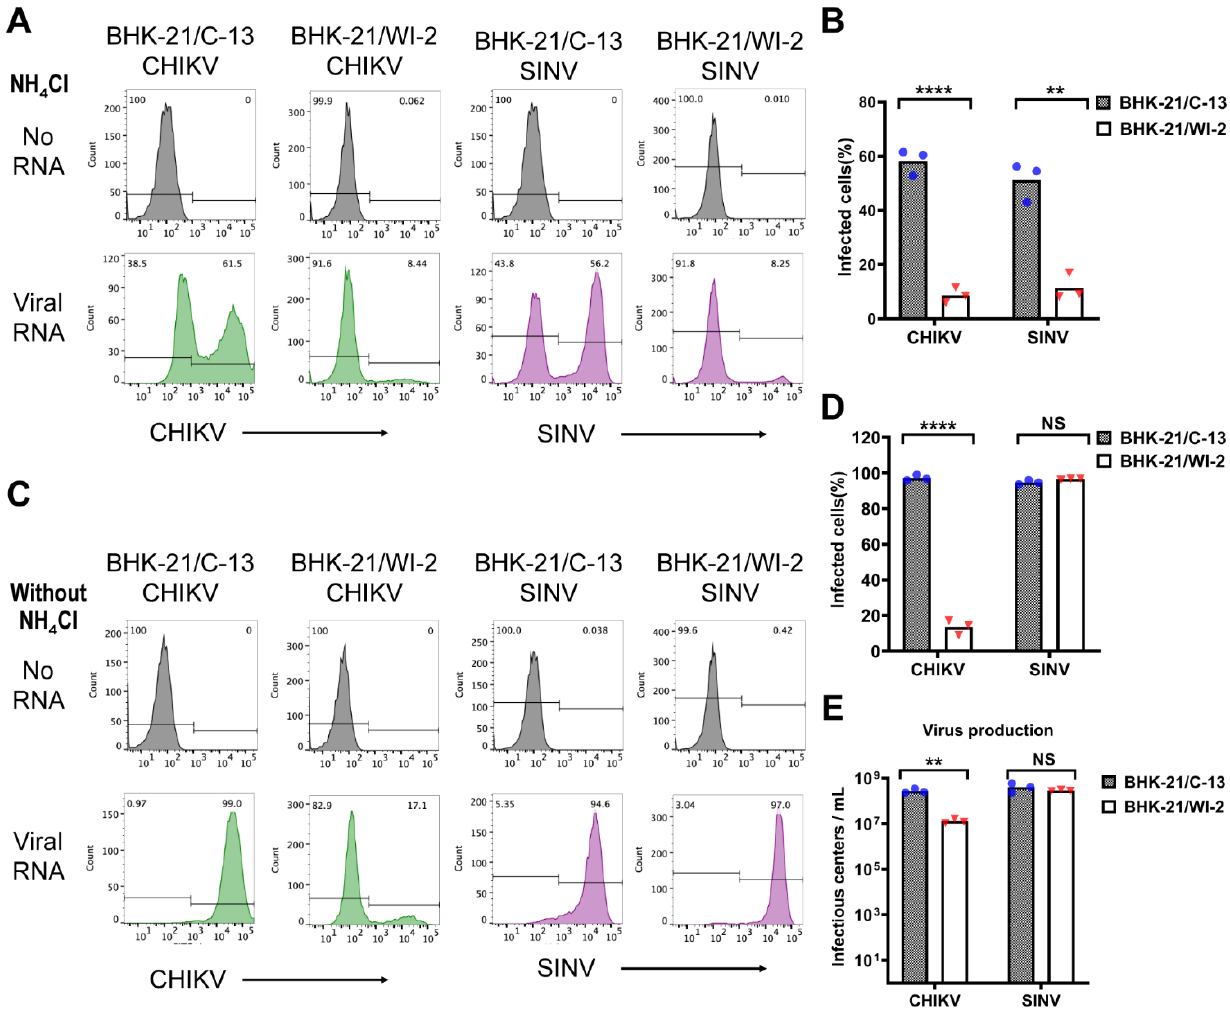
Figure 3. Viral RNA electroporation efficiency of BHK-21/C-13 and BHK-21/WI-2 cells. Equivalent numbers of BHK-21/C-13 or BHK-21/WI-2 cells were electroporated in parallel with in vitro transcribed CHIKV or SINV viral RNA. ( A , B ) After electroporation, cells were cultured in complete media for 2 h at 37 °C, then incubated at 28 °C overnight in media containing 20 mM NH 4 Cl to prevent secondary infection. ( A ) Infection was quantitated by flow cytometry. A representative example of 3 independent experiments is shown. ( B ) The bar graph represents the mean and individual data points of the % infection from 3 independent experiments. ( C – E ) After electroporation, cells were cultured in complete media for 2 h, then cultured in Med-A in the absence of NH 4 Cl for 10 h. ( C ) Infection was quantitated by flow cytometry. A representative example of 3 independent experiments is shown. ( D ) The bar graph represents the mean and individual data points of the % infection from 3 independent experiments. ( E ) The virus released in the medium was quantitated by infectious center assay. The bar graph shows the mean and individual data points from 3 independent experiments. For panels B, D and E, multiple t test was performed to assess the statistical significance of differences between BHK-21/C-13 and BHK-21/WI-2 cells. **, p < 0.01; ****, p < 0.0001.